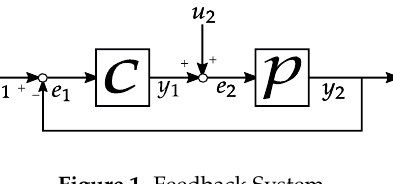
Figure 1. Feedback